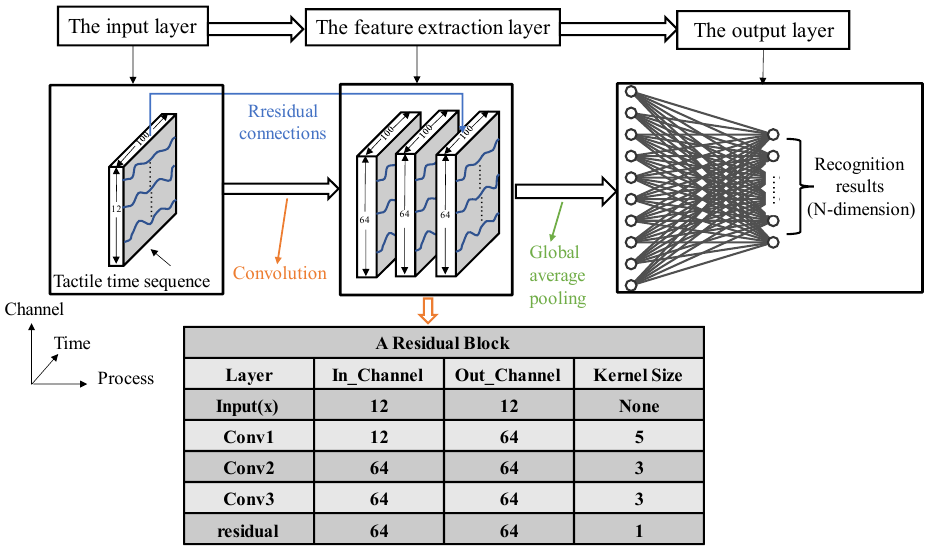
Figure 10. The residual network model for the tactile